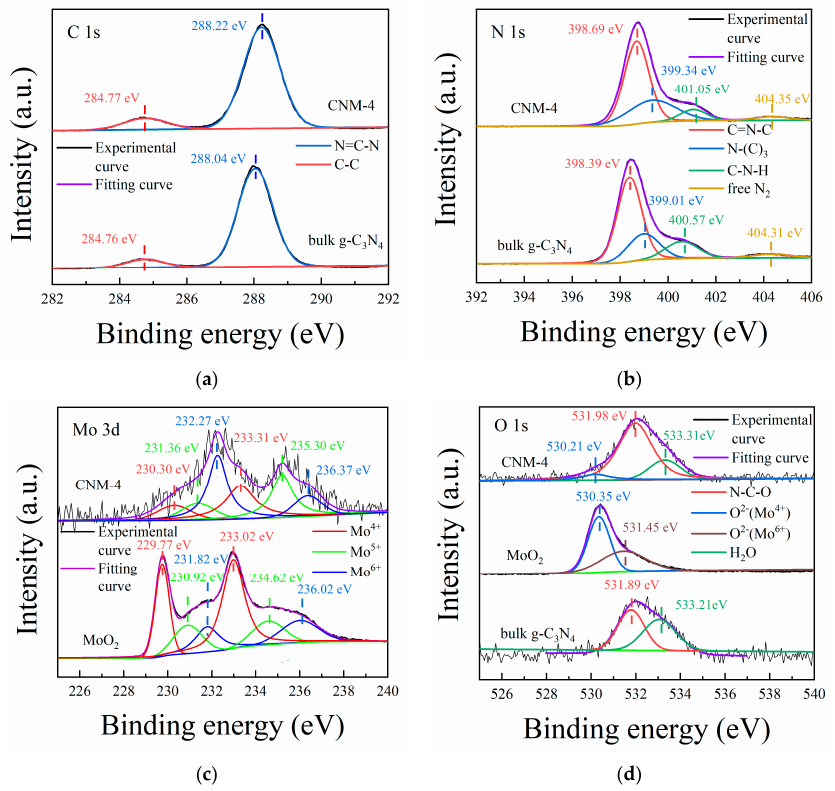
Figure 3. XPS spectra of the optimal composite CNM-4 in comparison with those of the control samples (bulk g-C 3 N 4 and commercial MoO 2 ): ( a ) C 1s, ( b ) N 1s, ( c ) Mo 3d, and ( d ) O 1s.